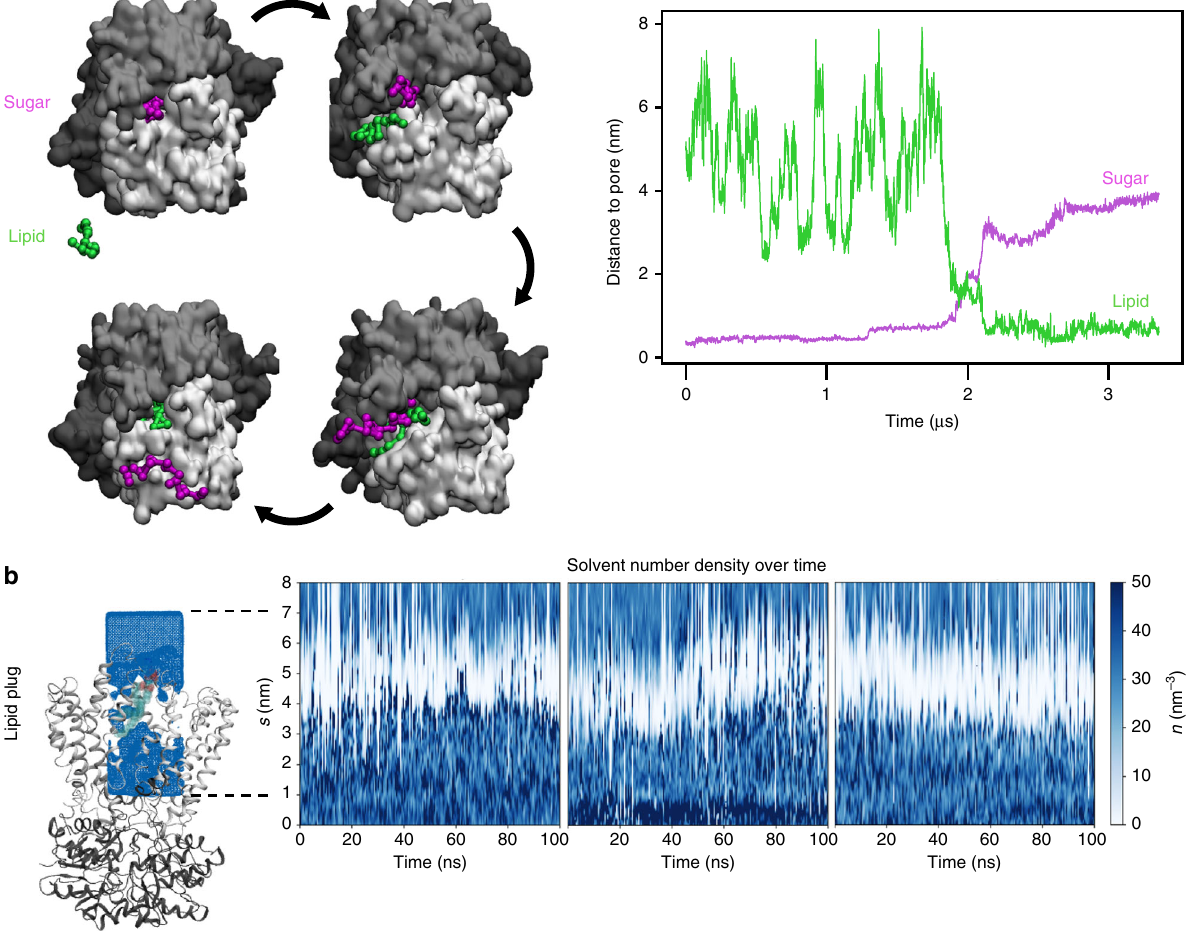
Fig. 4 Lipids gate the WzmWzt channel. a Details of the CG pulling simulations, with snapshots of a representative system viewed from the periplasm. Wzt is shown as black surface, and the two Wzm protomers are shown as light gray and white surfaces. The sugar molecule, which is pulled from the channel, is shown in pink and the replacing POPE molecule in green. The rest of the membrane is omitted for clarity. Right: Quanti fi cation of sugar – lipid swap for a representative simulation. b Post-100ns atomistic simulation snapshot of the lipid-engaged AaWzmWzt transporter and quanti fi cation of the water solvent density over the simulation, as per Fig. 3. The lipid molecule is shown as green and red transparent